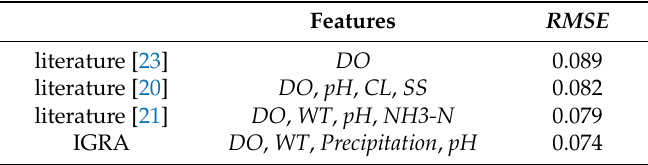
Table 3. Feature selection and prediction error of Tai Lake.